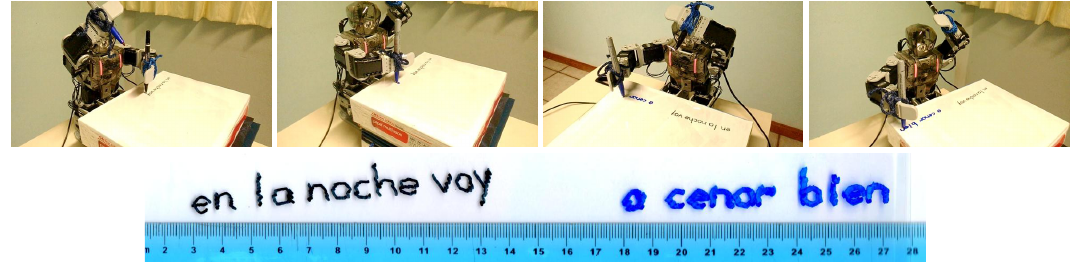
Figure 15. Transcription of a long sentence with the Bioloid’s left and right arm and the kinematic models ( r = 0.3